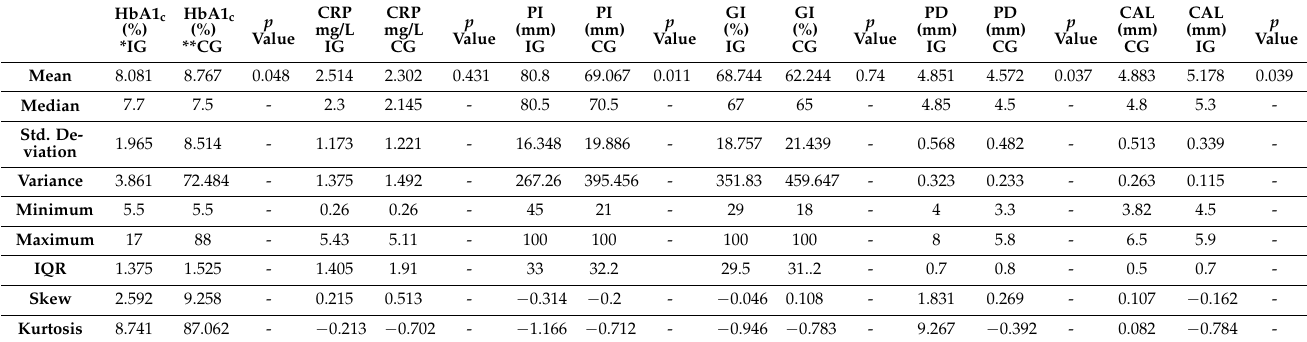
Table 2. Descriptive analysis of clinical parameters at baseline of both